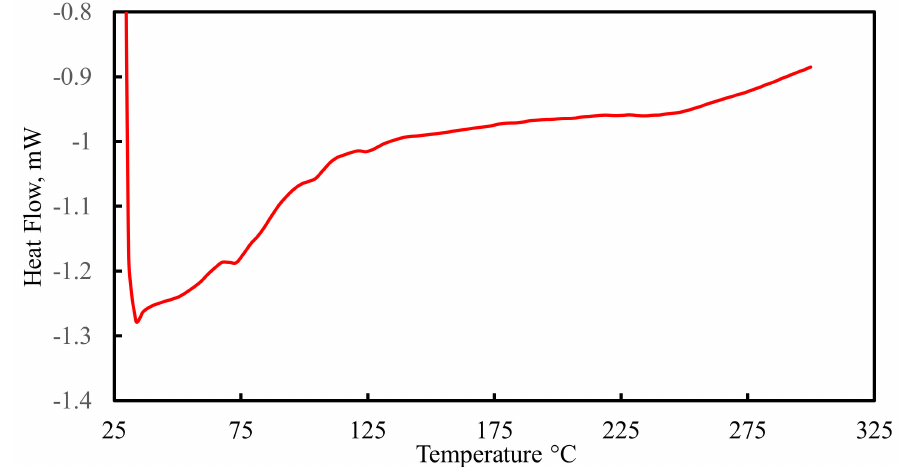
Figure 2. DSC of the nanosilica particles. The silica nanoparticles’ functional groups before interaction with the cadmium and copper ions were investigated, and the FTIR is shown in Figure 3. An absorption peak at 3160 cm − 1 and at 1636 cm − 1 is attributed to the -OH group and H–O–H vibrations [44]. The peak belonging to the Si–O–Si stretching vibration is at 1041 cm − 1 , and the peak around 778 cm − 1 corresponds to the Si–O–Si symmetric stretching [45].